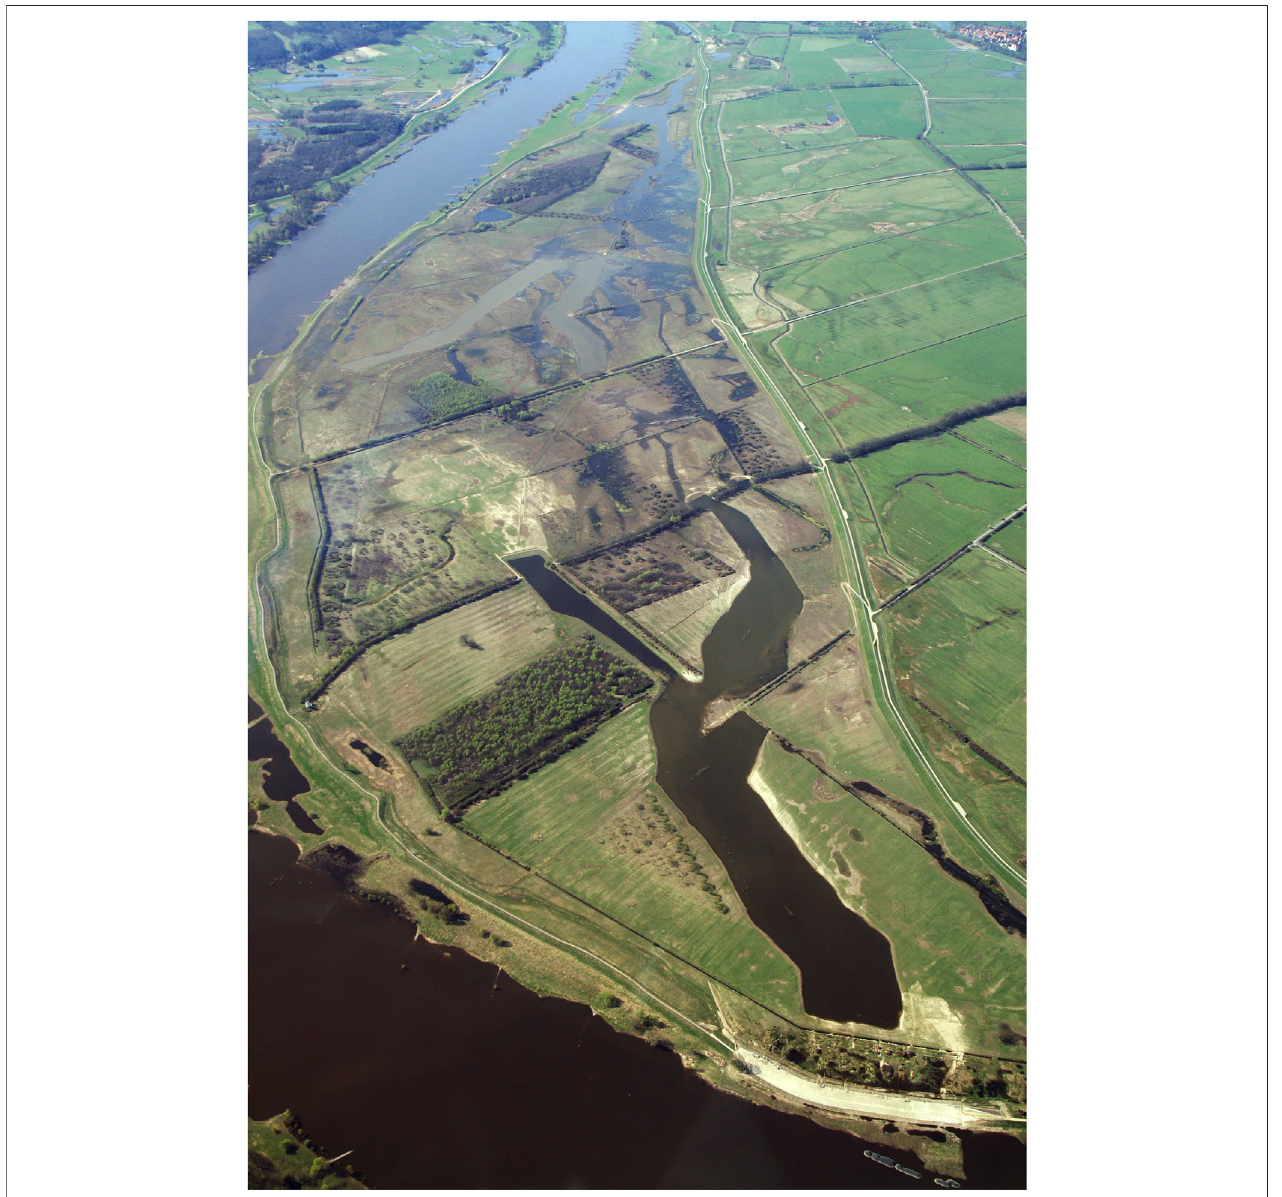
FIGURE 8 | Aerial view of the Middle Elbe River Levee Setback and River Restoration Project in the Lenzen Area (Germany) (courtesy of Katharina Nabel).